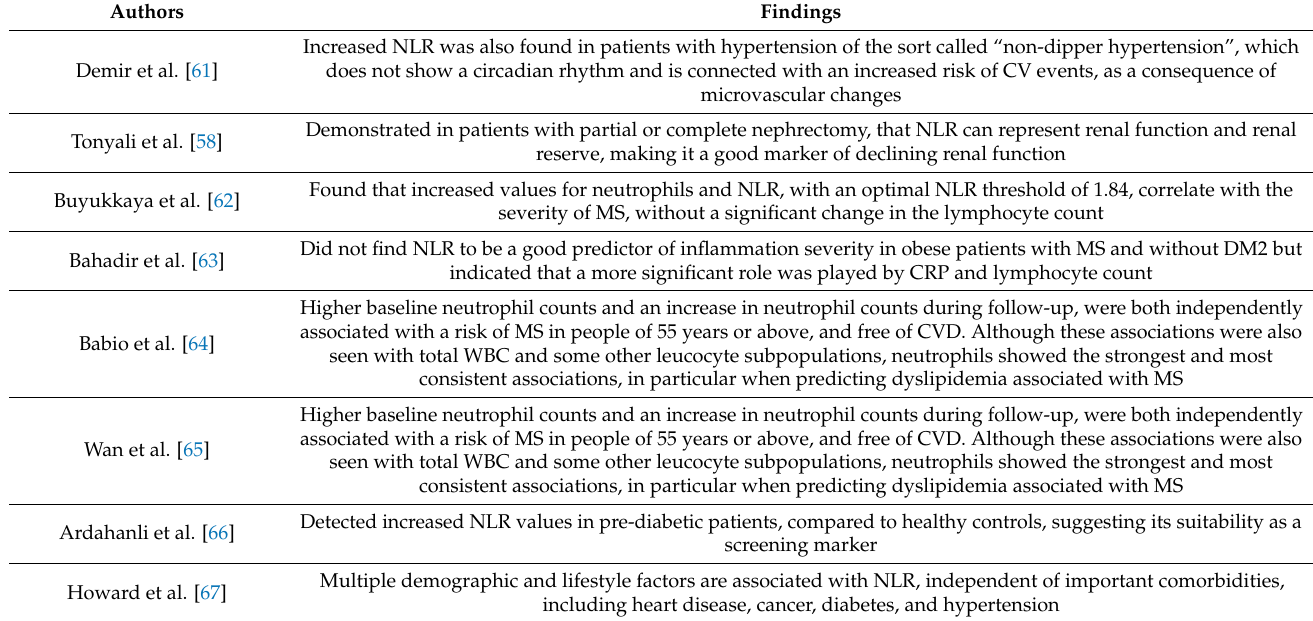
Table 2. Published papers in which NLR was assessed in the context of other cardio-metabolic